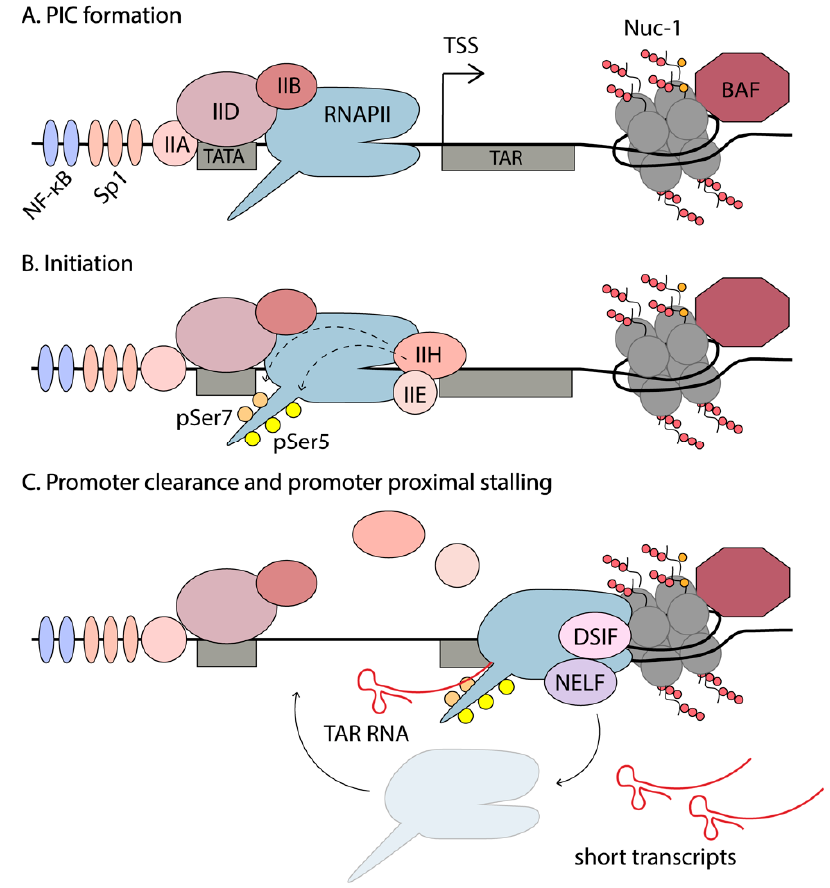
Figure 3. Pre-initiation complex formation and promoter proximal stalling. Even under latent conditions, there is an accumulation of RNAPII at the TSS. ( A ) The binding of host TFs, such as NF- κ B and Sp1, and general transcription factors TFIIA, TFIID, and TFIIB to their cognate sites, form the PIC on the HIV-1 promoter. Hypophosphorylated RNAPII is recruited to the PIC through interactions with these TFs. In this state, RNAPII is unable to initiate transcription. ( B ) The final general transcription factor to be recruited to the PIC is TFIIH. TFIIH binds directly to the DNA and the XPB subunit creates negative supercoiling and serves as a molecular wrench, threading the DNA through the RNAPII active site. The CDK7 subunit of TFIIH phosphorylates Ser7 and Ser5 of the RNAPII C-terminal domain (CTD) to activate the polymerase to begin transcription. ( C ) Once activated, RNAPII clears the promoter, transcribing the TAR RNA, but pausing just after due to the occlusion by Nuc-1 and the presence of the negative regulators DSIF and NELF. The paused polymerase then dissociates from the DNA and releases the short RNA transcript. RNAPII is then free to participate in PIC formation once again. Thus, there is an accumulation of RNAPII at the promoter of latent proviruses due to both occluded RNAPII in the PIC and stalled polymerases just after the TSS.